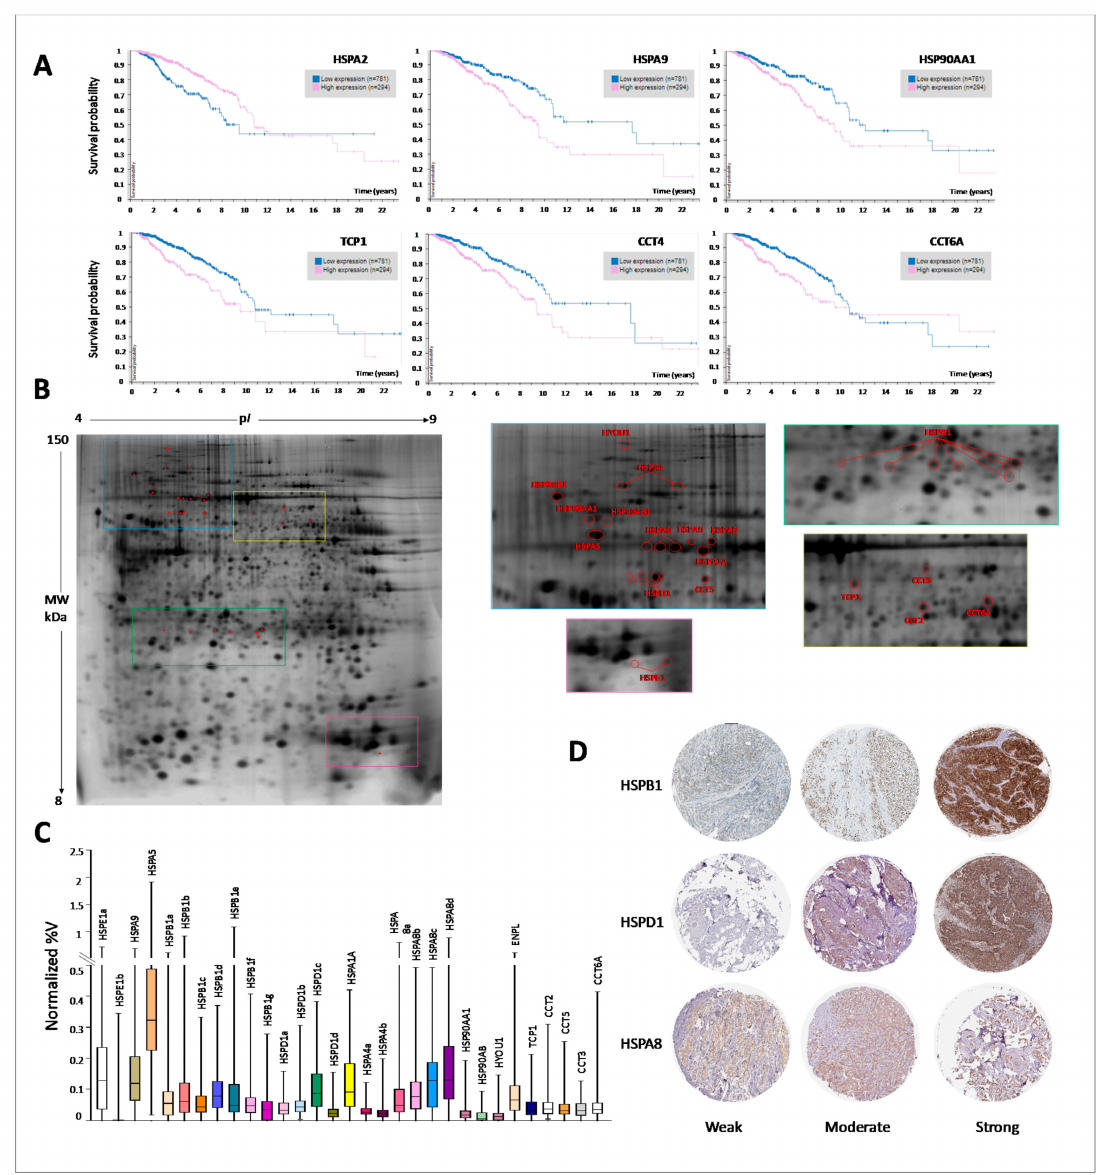
Figure 6. Proteomic expression of HSP members and prognostic significance. ( A ) Survival analysis of HSPs protein expression evaluated by immunohistochemistry (IHC) staining, using The Human Protein Atlas (HPA) database. The database was queried for each HSP member, and only significant analyses were reported; ( B ) Representative proteomic map of a breast cancer tissue. The 2-D separation was performed on IPG gel strips (18 cm, 3.0–10 NL) followed by the SDS-PAGE on a vertical linear-gradient slab gel (9–16%T). HSP protein members identified by Maldi-Tof spectrometry are marked with the Gene name. When present, different isoforms of the same protein were jointly labeled; ( C ) Quantitative analysis of HSP proteins, given as box-plot graph, in breast cancer tissues. Quantification was deduced by the 2D gels, analyzed by Image-Master software. In the ordinate are the values of N%V; ( D ) Representative IHC images for individual HSP proteins (HSPB1, HSPD1, and HSPA8) in breast cancer tissues showing weak, moderate and strong staining, respectively retrieved by the HPA database. The antibody immune reactivity was observed in several cell compartments, such as cytoplasm, plasma membrane as well as in